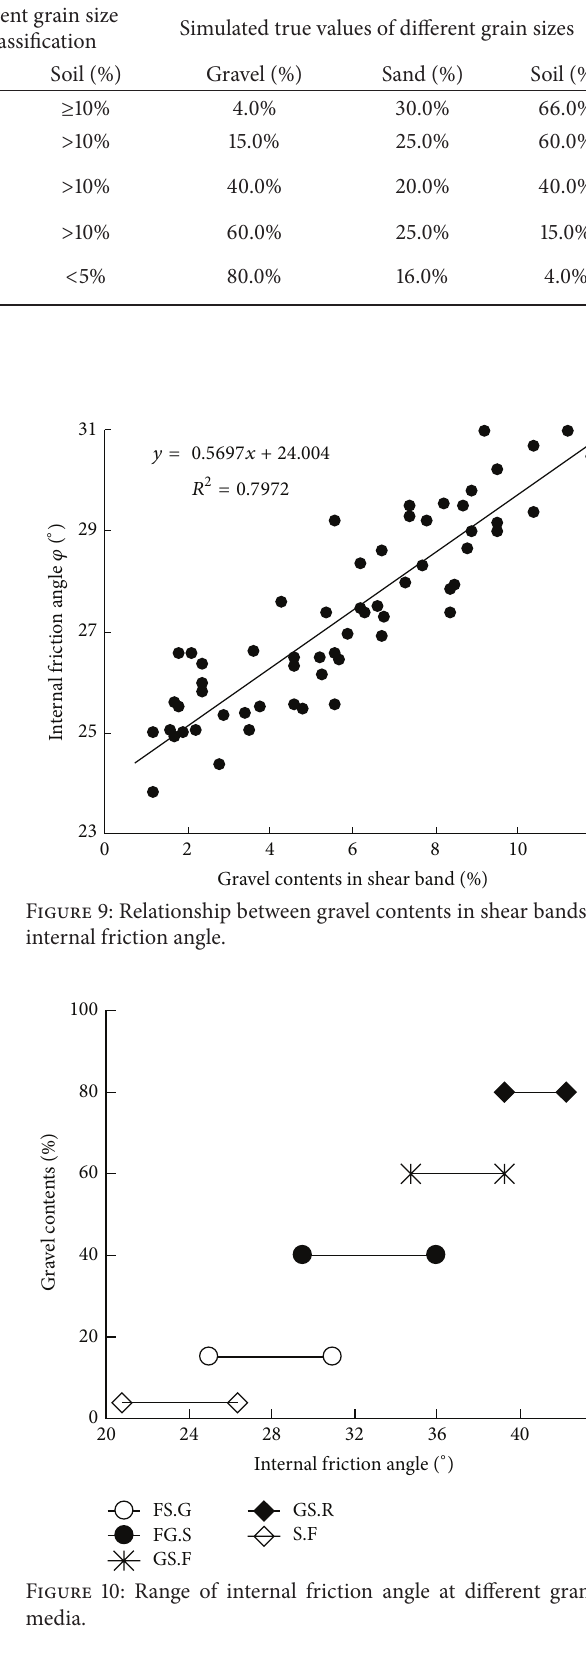
Table 2: Classification and gradation schemes of simulation tests of granular media.